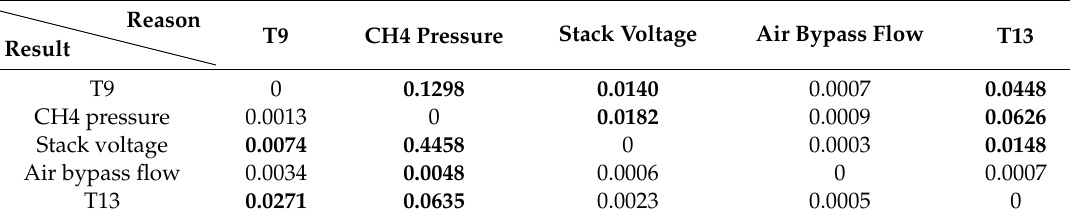
Table 3. Causality matrix based on time domain Granger causality